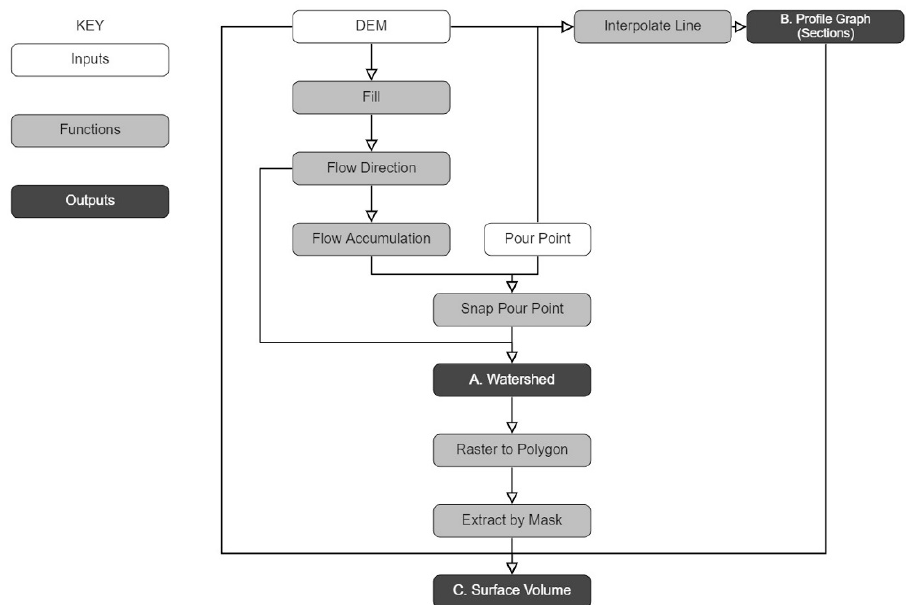
Figure 5. Workflow in ArcGIS to model stream network, watershed, profile graph and surface volume based on input DEM and pour point.